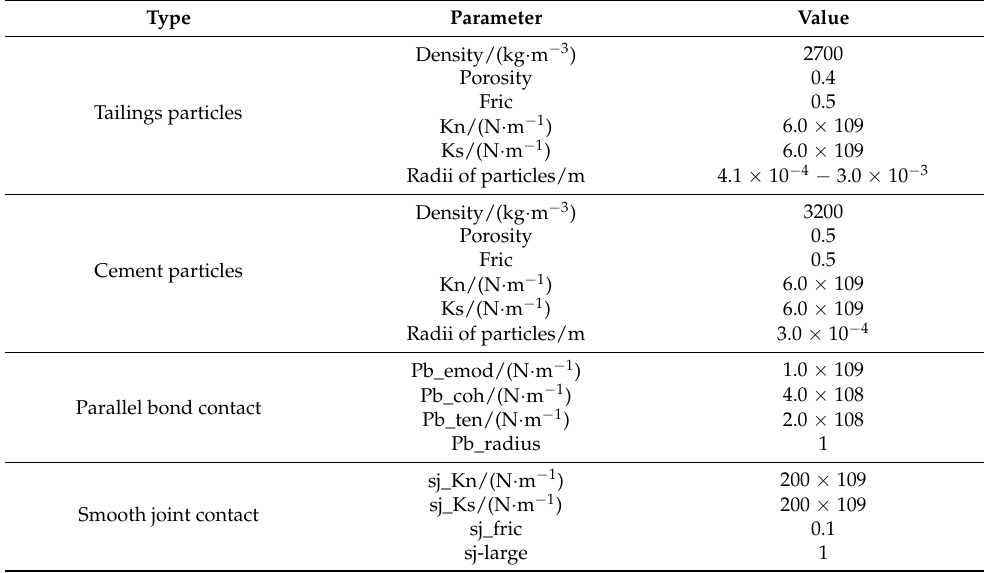
Table 7. Meso-mechanical parameters of numerical